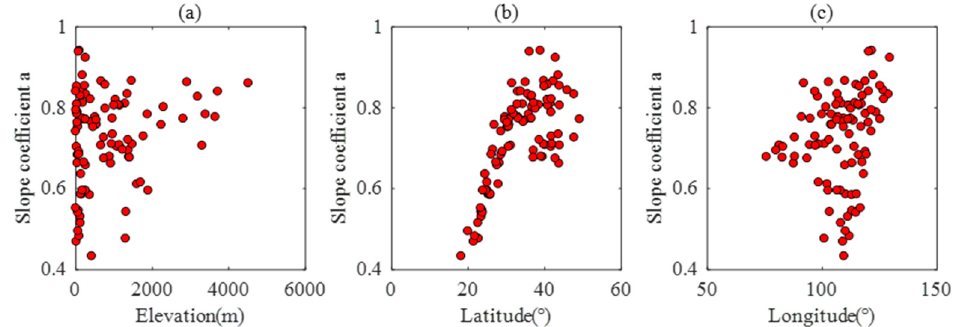
Figure 3. Distribution of the T m - T s model slope coefficient with the elevation ( a ), latitude ( b ), and longitude ( c ).